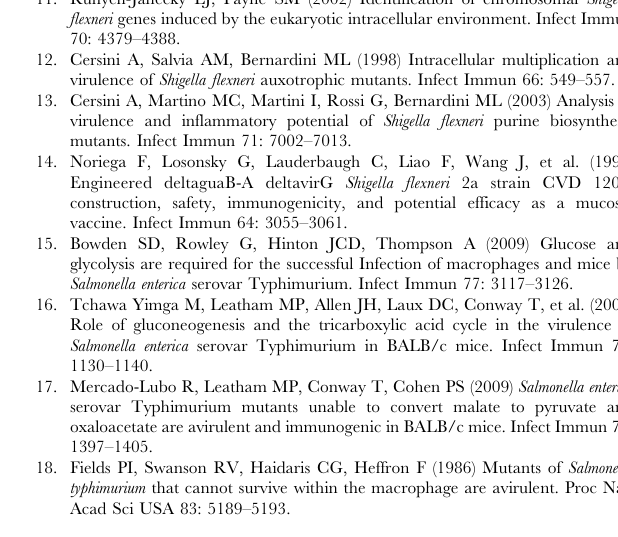
derives by PEP carboxylation. Figure S2 Metabolic model for delta ptsG, manXYZ, uhpT mutants (impaired in the uptake of glucose and glucose 6- phosphate) of enteroinvasive Escherichia coli ( EIEC HN280 and EIEC 4608-58) and Salmonella enterica Serovar Typhimurium ( Stm 14028) replicating in Caco-2 cells in the presence of 10 mM [U- 13 C 6 ]glucose. The bacteria are indicated by the large boxes. Host cell metabolites and reactions are shown outside these boxes. Contiguous 13 C-label is indicated by red bars. Single labelled isotopologues are indicated by red dots. Metabolic flux observed under the various conditions is indicated by blue arrows. The relative flux rates (on the basis of the detected 13 C-enrichments in amino acids) are symbolised by the widths of the arrows. 13 C- enriched amino acids detected are shown in boxes. The numbers indicate the molar contributions (%) of the major 13 C-isotopolo- gues detected by MS. The positional 13 C-label distributions (as indicated by the bars and dots) are predicted on the basis of the metabolic reactions in the model. This model is based on the lack of efficient glucose uptake. In this case, intracellular metabolism is shifted to an increased uptake of C 3 -compounds which may be shuffled into the central carbon metabolism at the level of pyruvate. alpha-Ketoglutarate as well as oxaloacetate are derived in this case from the citrate cycle. Labelling patterns due to two rounds of citrate cycling are given in purple. Under these conditions, amino acids are imported from the host cells more efficiently (indicated by the arrow widths). Table S1 Composition of the standard RPMI 1640 medium used in the present study. (Gibco: http://www.invitrogen.com/ site/us/en/home/support/Product-Technical-Resources/media_ formulation.116.html).